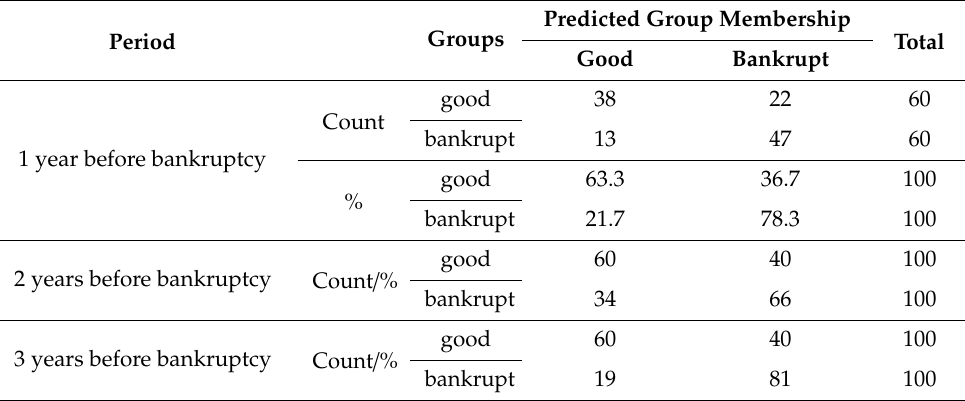
Table 5. Classification results from discriminant